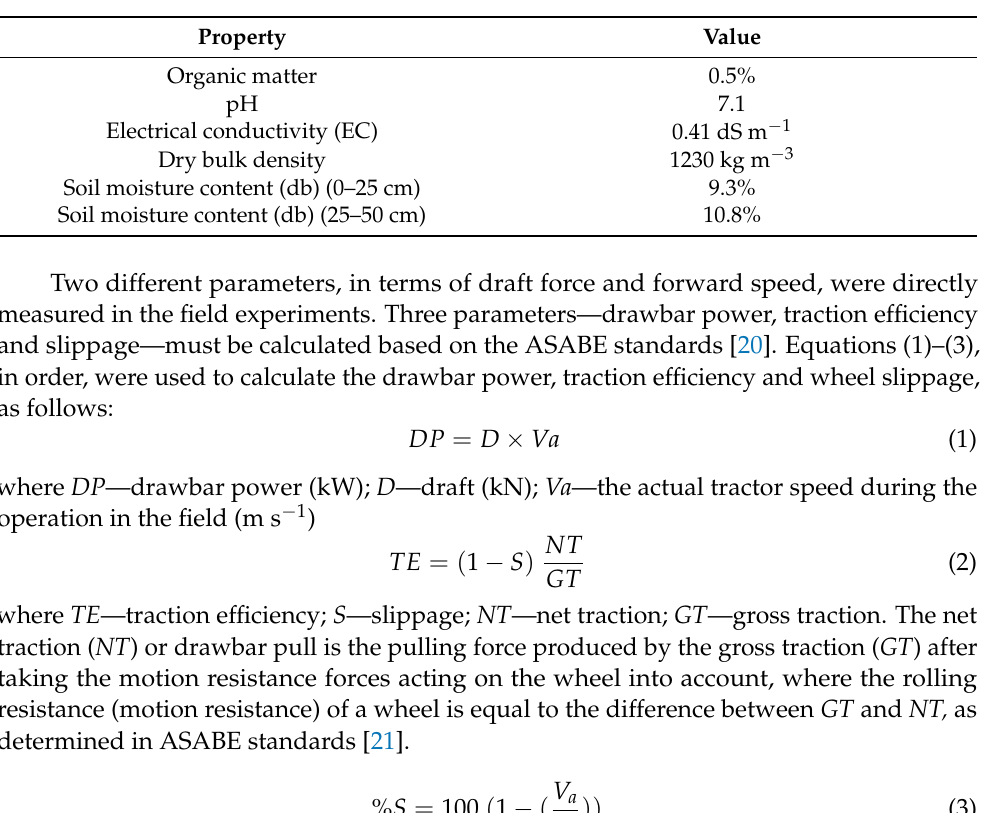
Figure 2. Results of soil cone index. Table 1. Data obtained from field soil